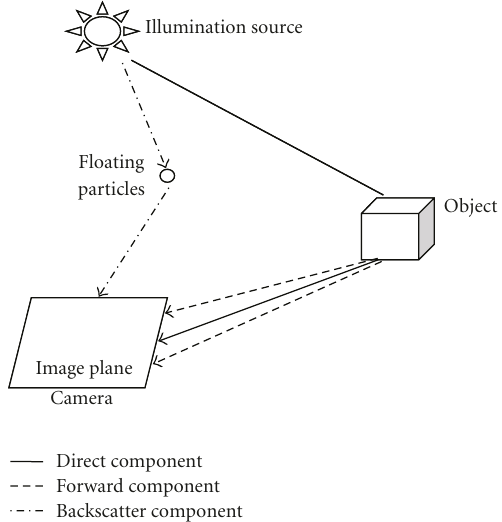
Figure 1: The three components of underwater optical imaging: direct component (straight line), forward component (dashed line) and backward scatter component (dash-dot line).